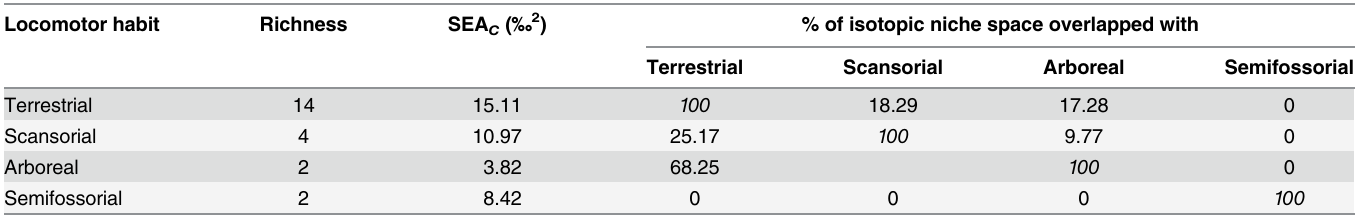
Table 3. Richness, area occupied by the isotopic niche space (SEA C ) and percentage of isotopic niche space overlap between locomotor habit groups of small mammals three sites of the Atlantic